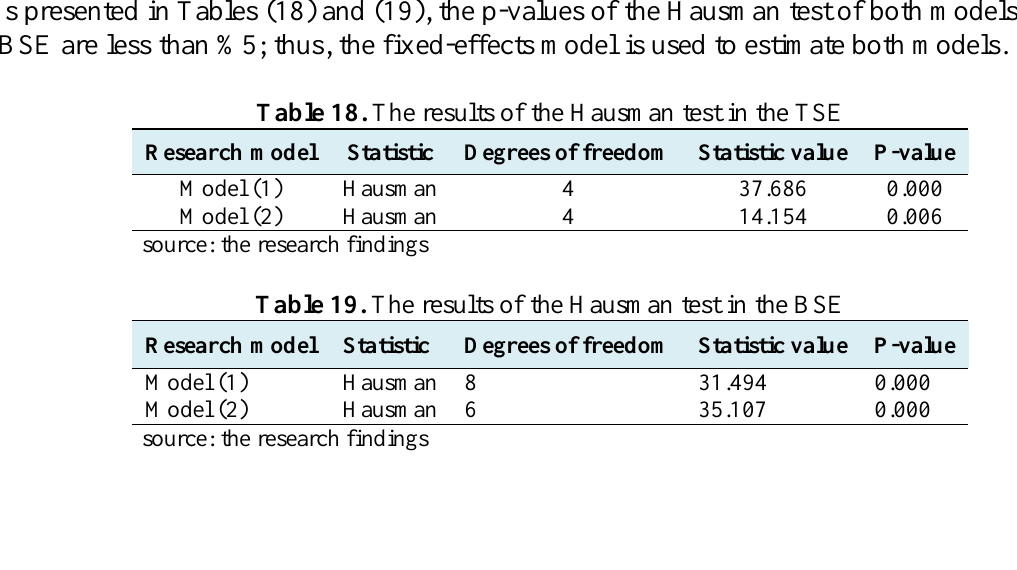
Result P-value The Levin-Lin-Chow statistic Variables